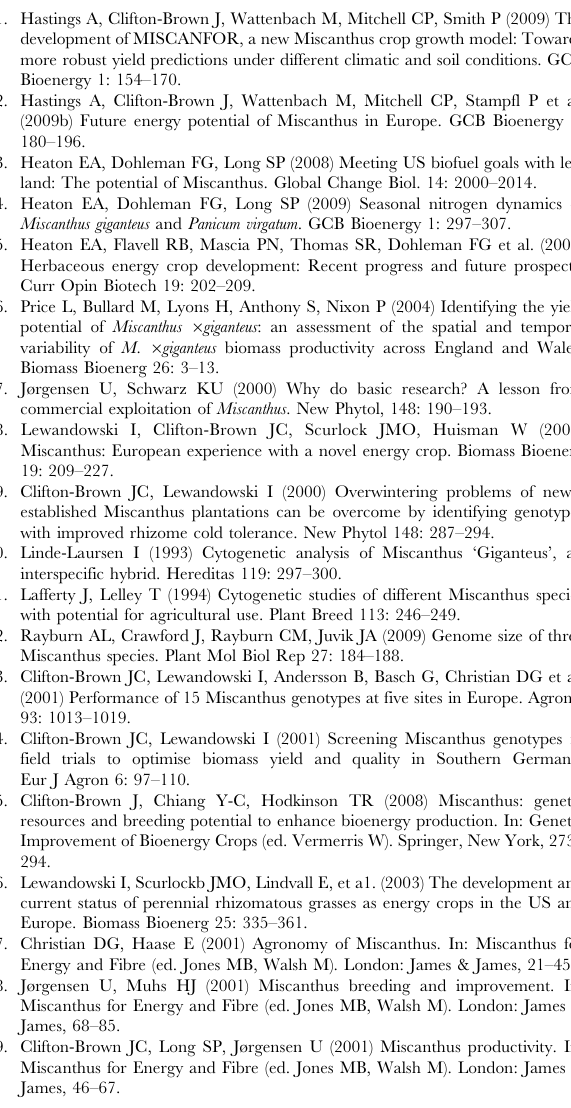
Table S3 The phenotypic data, biomass yield, plant height and heading time for each M . sinensis accessions in 2009 and 2010. Table S4 The genotypic data of 115 alleles in the M . sinensis